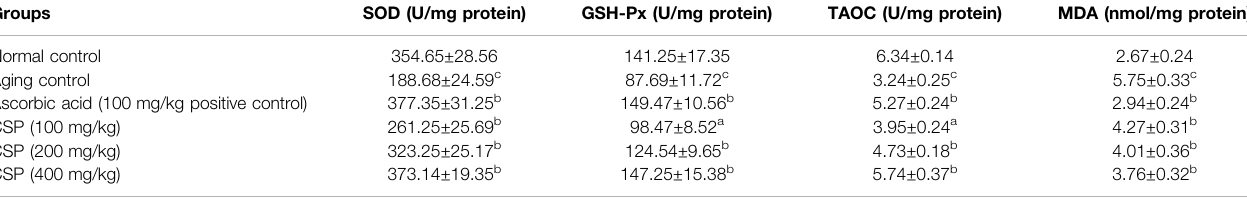
TABLE 4 | Effects of CSP on the activities of SOD, GSH-Px, TAOC and MDA levels in livers in aging mice.